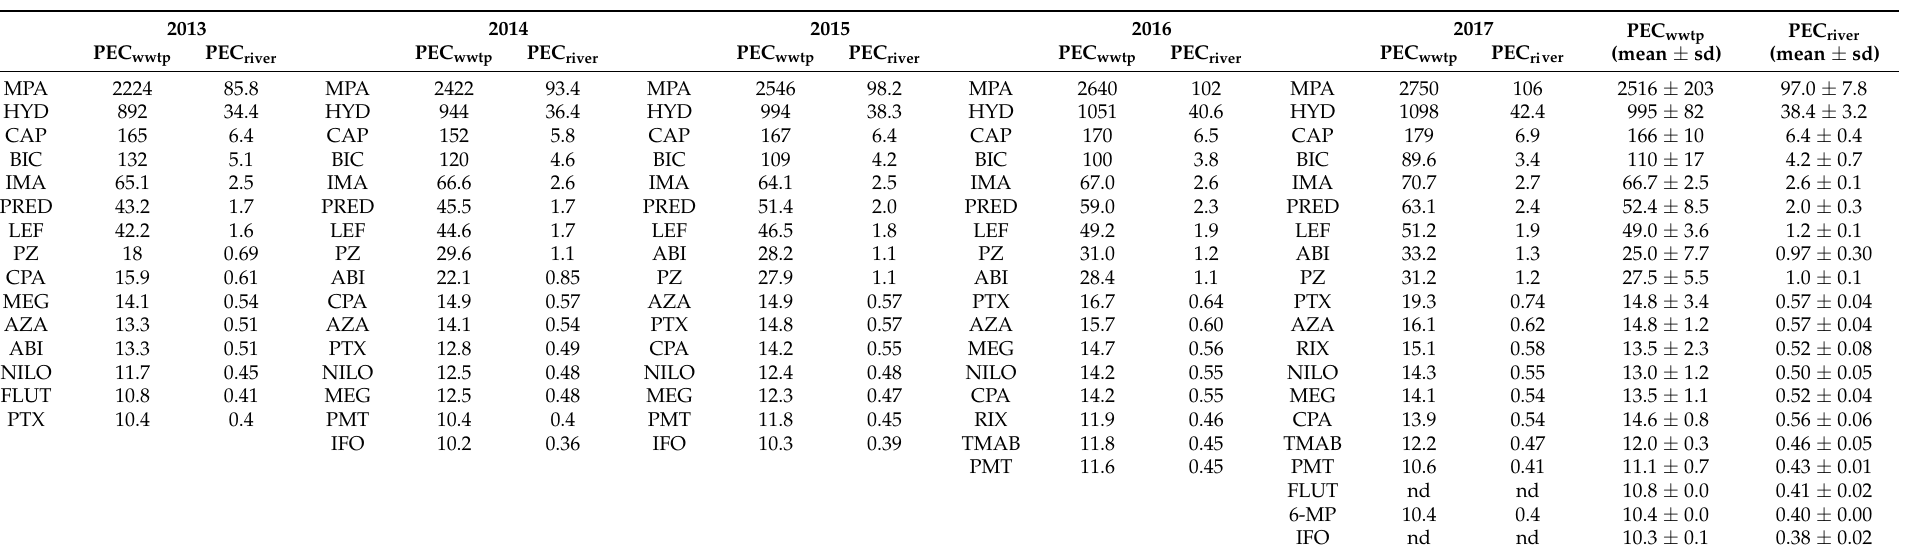
Table 2. Cytostatic drugs with the highest values of PEC wwtp and PEC river (in ng L − 1 ) in the period of 2013–2017 and mean values from PEC wwtp and PEC river . Mycophenolic acid (MPA); Hydroxycarbamide (HYD); Capecitabine (CAP); Bicalutamide (BIC); Imatinib (IMA); Prednisone (PRED); Leflunomide (LEF); Abi- raterone (ABI); Pazopanib (PZ); Paclitaxel (PTX); Azathioprine (AZA); Rituximab (RIX); Nilotinib (NILO); Megestrol (MEG); Cyproterone (CPA); Trastuzumab (TMAB); Pemetrexed (PMT); Flutamide (FLUT); Mercaptopurine (6-MP); Ifosfamide